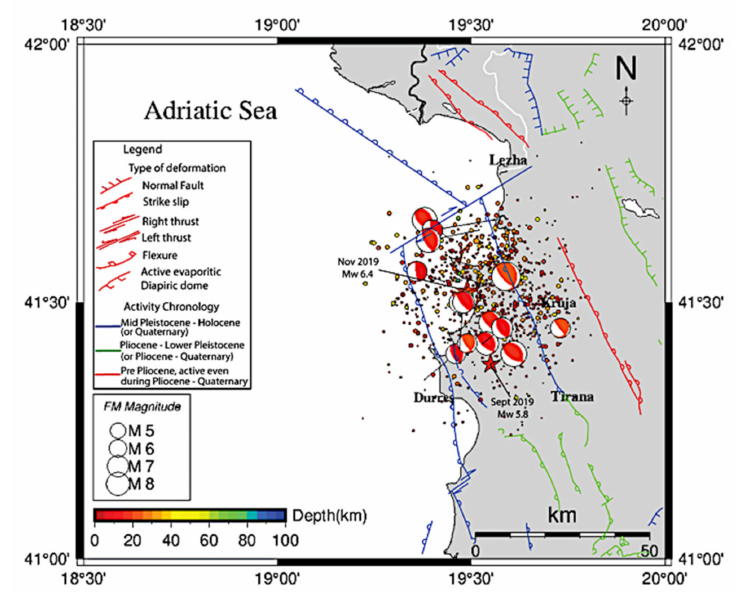
Figure 2. Seismic sequence of September 2019–June 2020, corresponding focal mechanism solutions (FM) of the larges shocks and the active faults influencing Durres region.